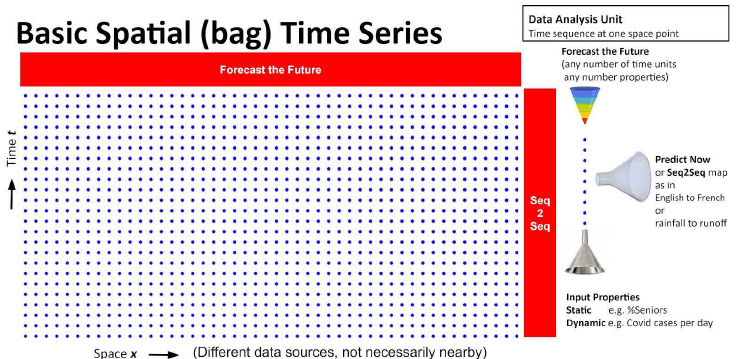
Figure 8. Illustration of a spatial bag with associated time sequences. t labels time and x location. The Seq2Seq and forecast modes are illustrated as well as the structure of input data and